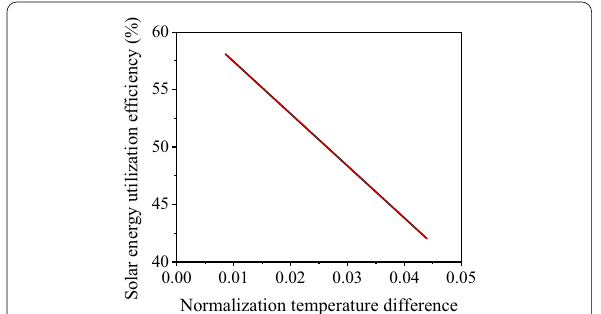
Fig. 4 Relationship between normalization temperature and solar energy utilization efficiency